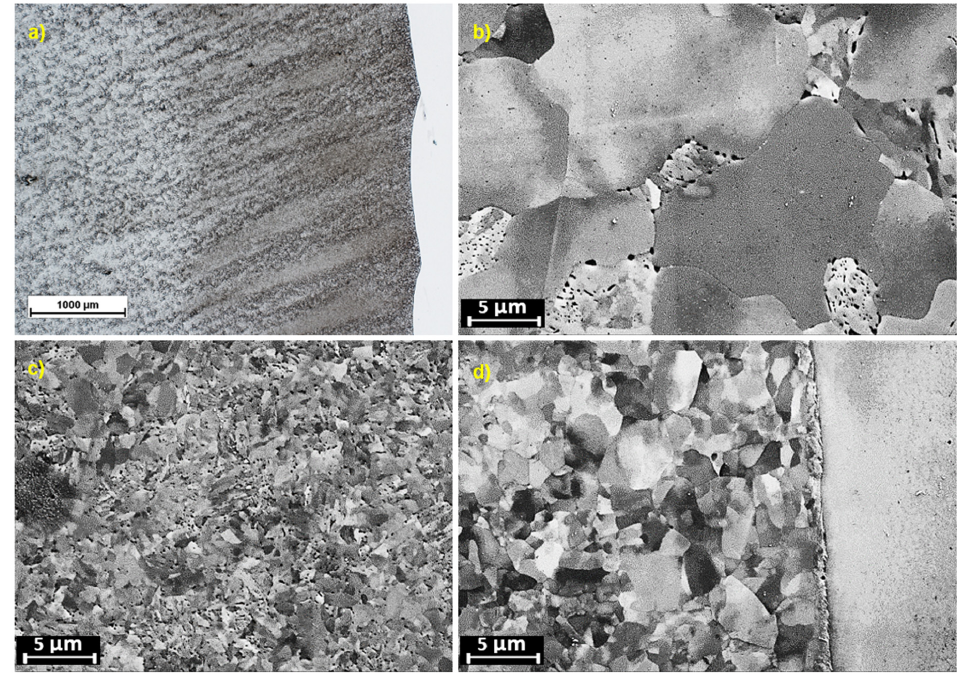
Figure 2. Typical features of the LAS heat-affected zone (HAZ) of the DMW mock-ups, with ( a ) an optical image of the LAS HAZ of NIWEL AR. Note that the wavy pattern of the FB was due to the weld passes and the banded structure in the LAS. SEM imaging of the LAS HAZ in SINI mock-up shows ( b ) the LAS base material, ( c ) the grain-refined zone and ( d ) the grain-coarsened zone and the carbon-depleted zone (CDZ) next to the fusion boundary (FB). Metals 2020 , 10 , x FOR PEER REVIEW